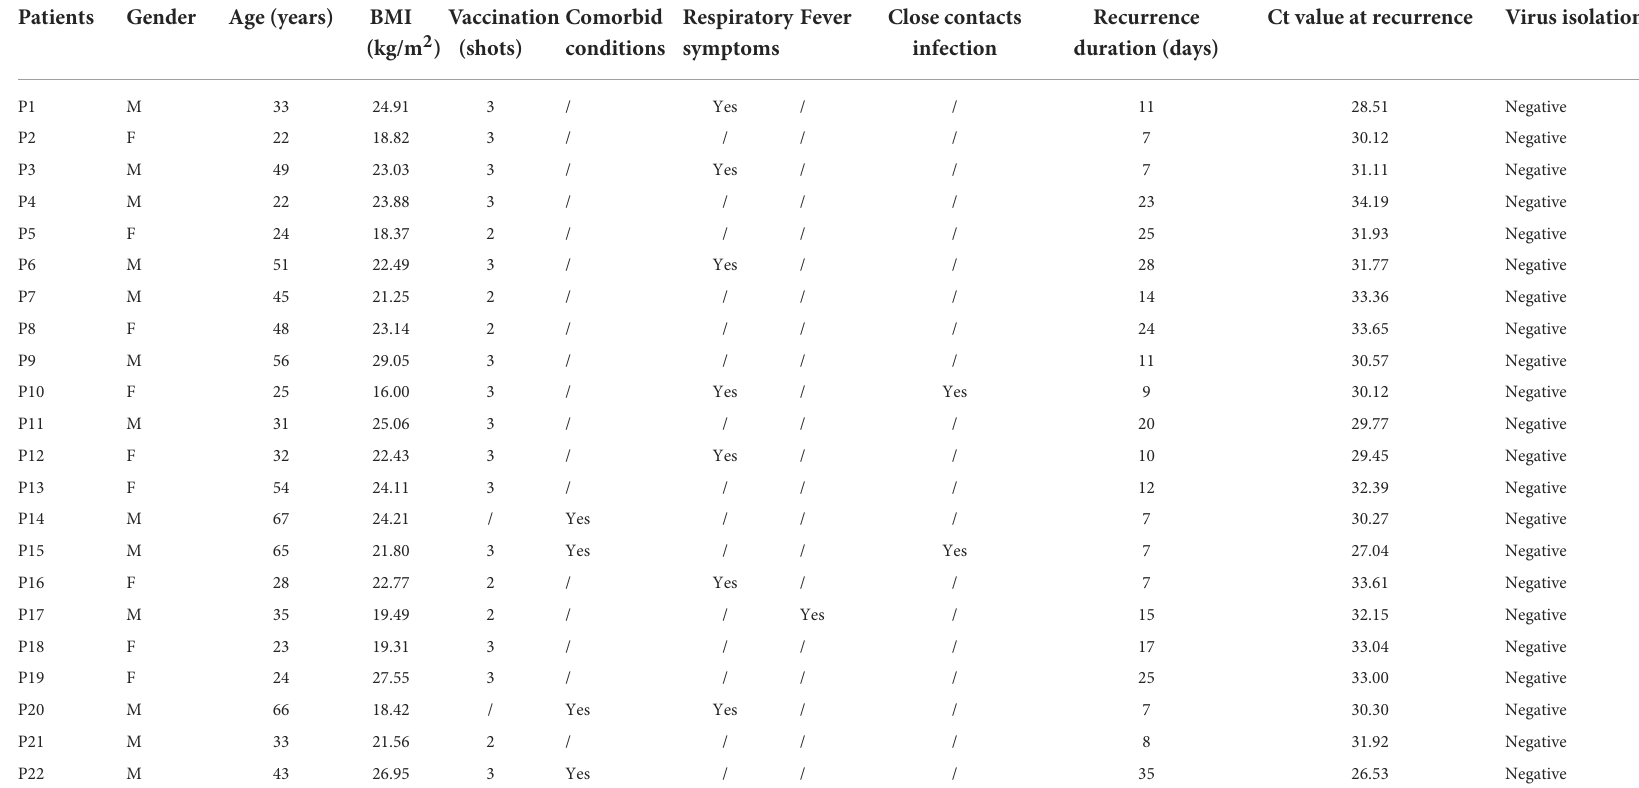
TABLE 3 Characteristics of randomly selected patients for virus isolation. Patients